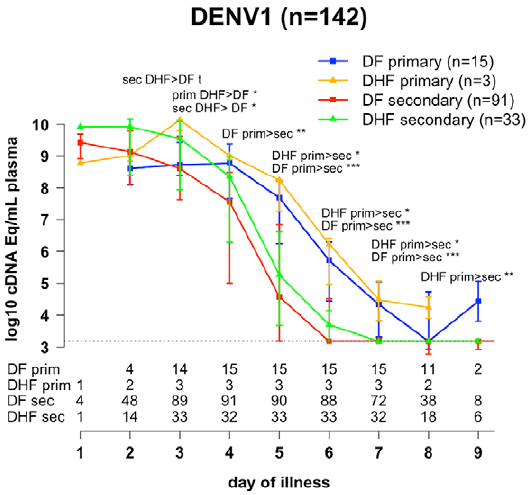
Figure 2. Magnitude of DENV-1 viremia by illness day. Levels of DENV-1 genome equivalent cDNA copies per millilitre were determined in serial plasma samples from DENV-1 infected patients with primary DF (n=15), primary DHF (n=3), secondary DF (n=91) and secondary DHF (n=33). Data are median and IQR. *** P , 0.001 ** 0.001 , P , 0.01 * 0.01 , P , 0.05 t 0.05 , P , 0.1. The numbers below the graph indicate the numbers of patients at each time point (2 per patient for most of the time points). The dashed line represents the assay limit of